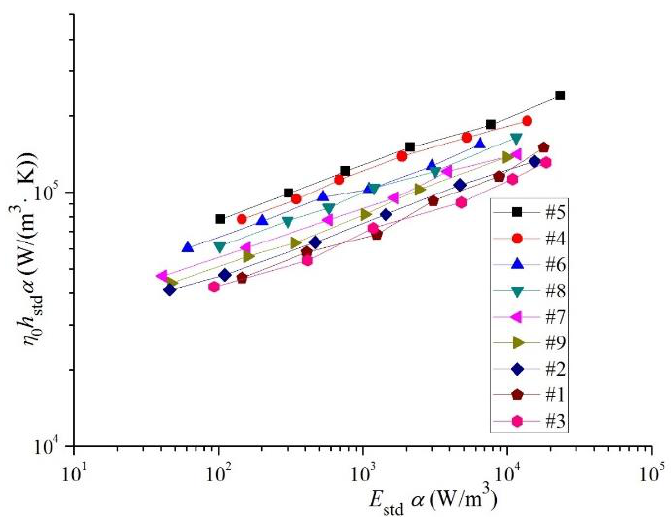
Figure 7. Comparison of core volume goodness factor of different circular-arc-shaped flow chan- nels.